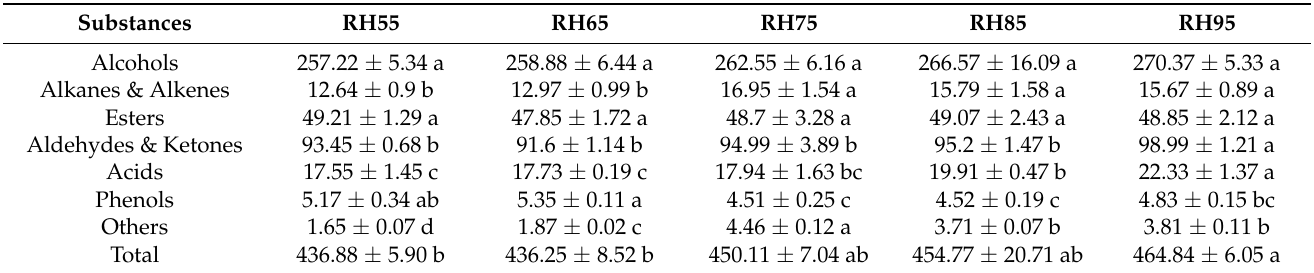
Table 2. Effect of fermentation humidity on the contents of different volatile species in congou black tea. ( µ